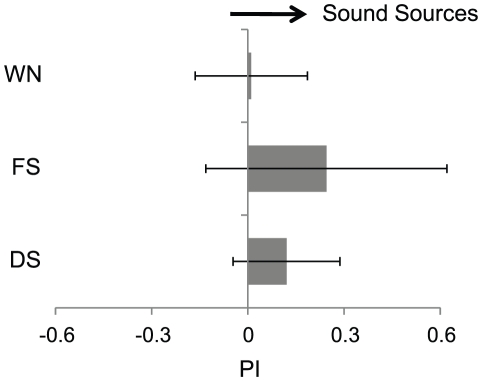
Honeybees' localization toward a single sound source.The left column indicates the types of sounds: dance sounds (DS), flight sounds (FS), and white noise (WN). Nine honeybees were tested in this experiment. The error bars indicate standard deviations. The grey areas show the mean performance indices (PI) for a 22-sec flight period. PI was calculated for these periods as a ratio of (t1−t2)/(t1+t2), where t1 indicates the duration during which the honeybee orients towards the current sound source and t2 indicates the duration during which the honeybee turns away from it. The starting position of a sound source was shifted randomly. Since PI's are 0.12±0.17 and 0.25±0.38 for dance (DS) and flight (FS) sounds, respectively, their non-zero hypotheses are significant with P<0.01. In contrast, since PI is 0.01±0.18 for white noise (WN), the non-zero hypothesis is not significant with P>0.05.